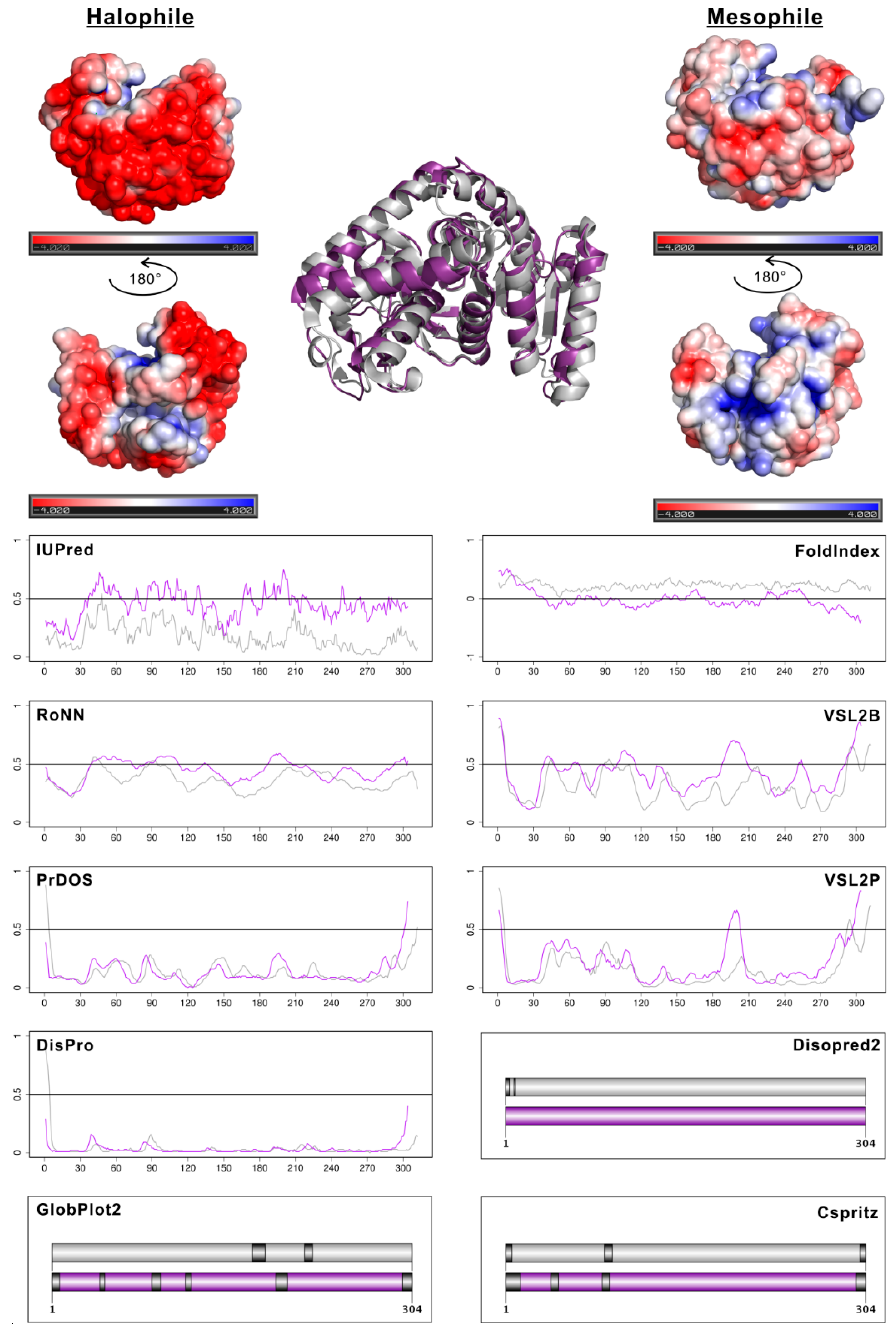
Figure 5. Disorder predictions with ten methods for a halophilic and a mesophilic malate–dehydrogenase enzyme. The halophilic enzyme from Haloarcula marismortui (PDB:1D3A) is shown on the left and with purple color in the structural alignment and within the disorder prediction plots. The mesophilic enzyme from Bacillus anthracis (PDB:3TL2) is shown on the right and with grey color in the structural alignment and within the disorder prediction plots. For the different disorder prediction methods, order–disorder thresholds were defined as suggested in their respective original publications. In each case values are above the probability threshold mean disorder, except for FoldIndex where it is the opposite. For the seven methods that provide continuous values for disorder probability we show the predicted values as curves. The curves are continuous and just placed on each other, not fitted/aligned. Purple curves show the predictions for the halophilic, grey ones for the mesophilic enzyme. For the three methods that only provide a binary classification of residues as ordered/disordered we show the proteins as colored bars with the predicted disordered regions depicted as dark grey stripes and with the length of the halophilic protein indicated.